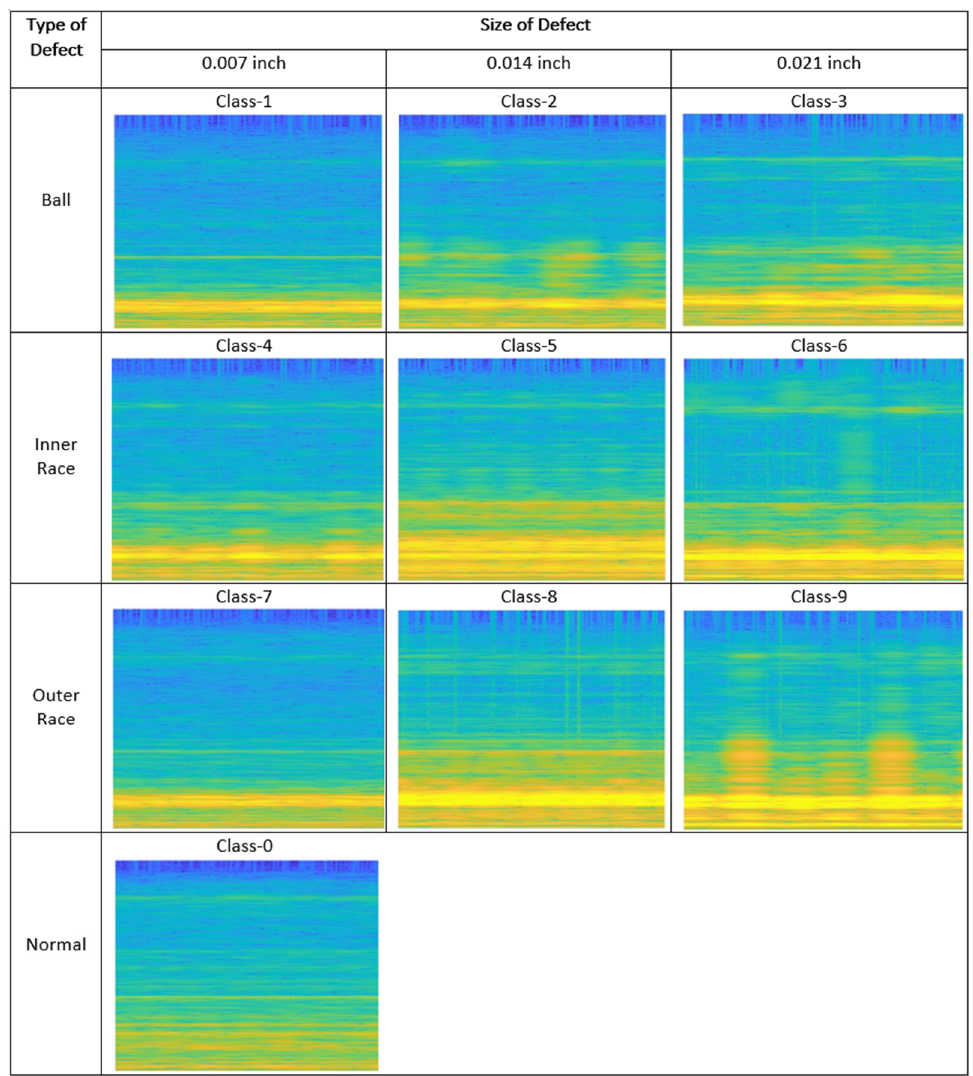
Figure 4. Spectrogram images for different defect classes listed in Table